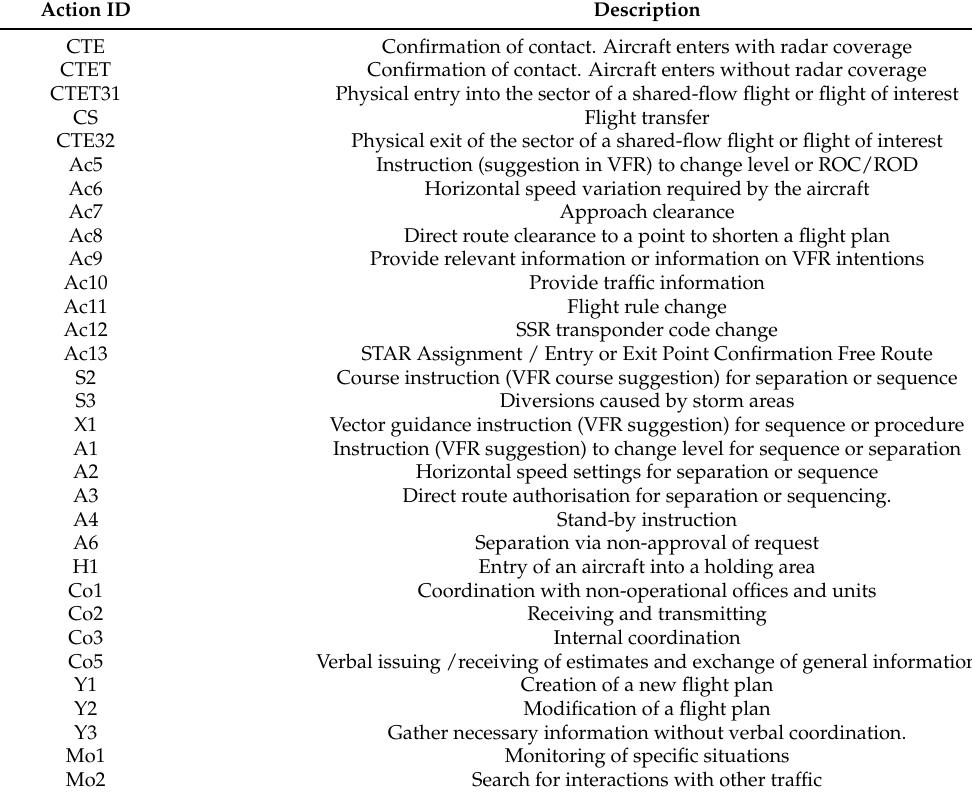
Table 1. IDs of each possible ATCo